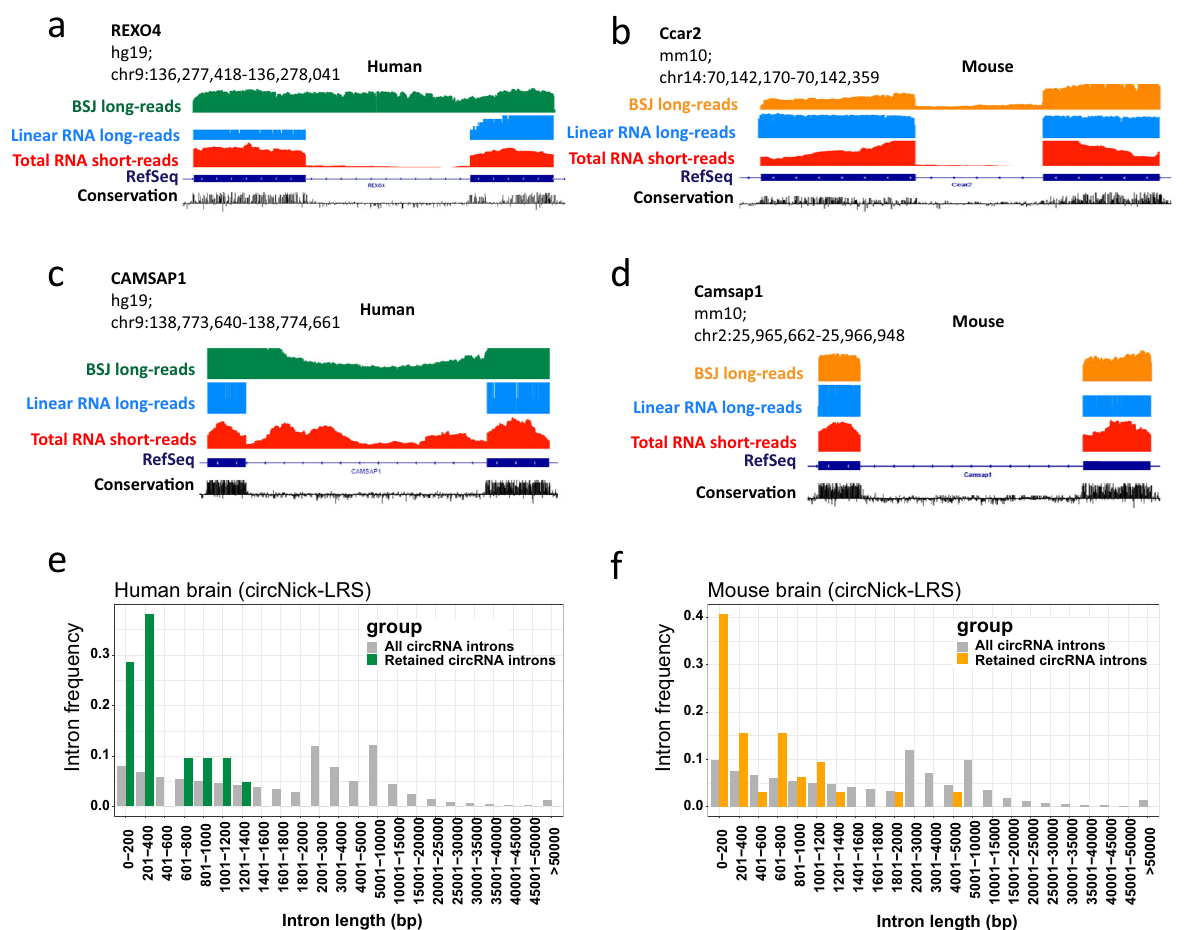
Fig. 3 Examples of intron retention events in circRNAs and their frequency and length distribution. a Human circREXO4 contains a retained intron not detected in linear mRNA. b Mouse CircCcar2 generates different isoforms with retained introns. c , d CircCAMSAP1 is conserved between human and mouse but only the human circRNA shows intron retention. e , f The frequency of intron retention in comparison to intron length across all annotated introns in circRNAs genome-wide. Gray bars, frequency of all circRNA introns; green and yellow bars, frequency of retained circRNA introns in human and mouse, respectively. See legend to Fig. 2 for the explanation of